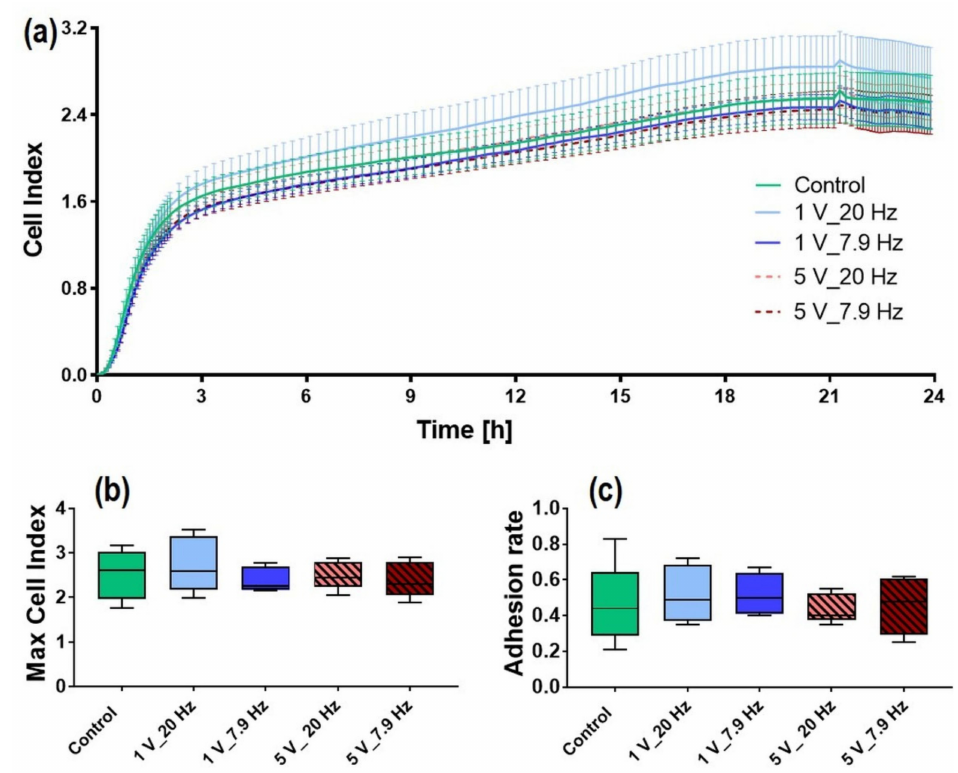
Figure 6. AC-stimulated liquid DMEM and influence on a long-time MG-63 cell adhesion via impedance measurement. ( a ) Cell adhesion and spreading expressed by the “Cell Index” parameter over 24 h. (xCELLigence RTCA; 5 independent experiments, mean ± s.e.m.; multiple t-tests, n.s.) ( b ) Maximal Cell Index (values after 24 h), and ( c ) corresponding cell adhesion rate (Cell Index at the time point when 50% of the cells adhere). Note that AC-stimulated liquids did not influence the cell’s adhesion capacity. (xCELLigence, 5 independent experiments; median ± min/max; one-way ANOVA posthoc uncorrected Fisher’s LSD,